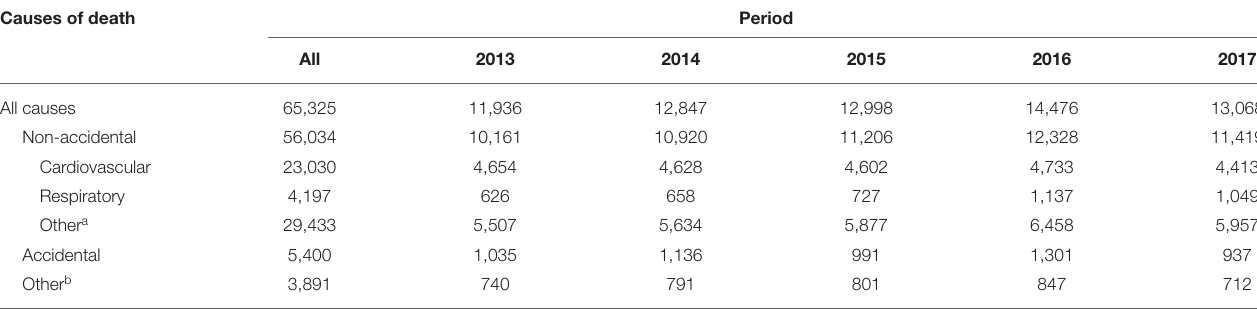
TABLE 1 | Summary statistics for mortality in Shenzhen,